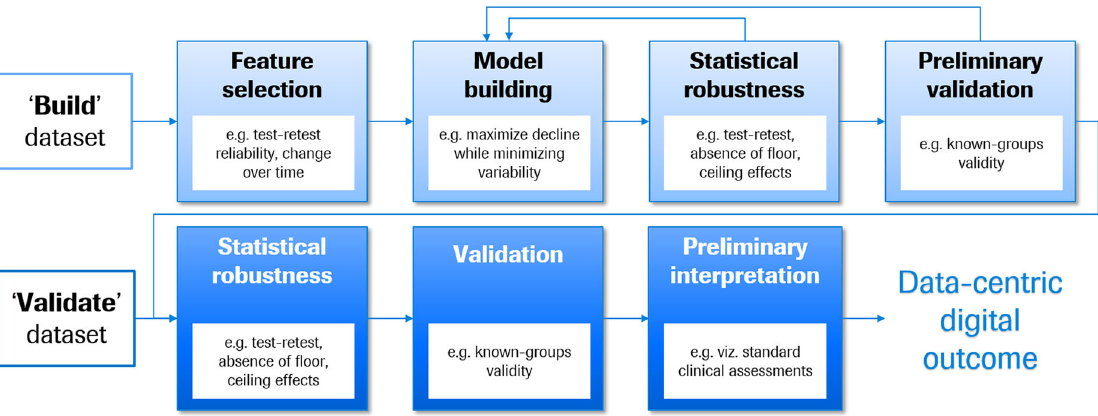
Fig. 2 A roadmap to build and validate a data-centric digital outcome measure to monitor disease progression. A build dataset is used to select robust features for model building. The model building procedure is iterative, beginning with the generation of preliminary models tailored to the concept of interest, followed by tests for statistical robustness and preliminary validation. An independent validate dataset is used to con fi rm the statistical robustness of the model, validate that the model performs as expected, and support preliminary interpretation of the score magnitudes via comparisons with reference clinical assessments. Leftward arrows denote iterative